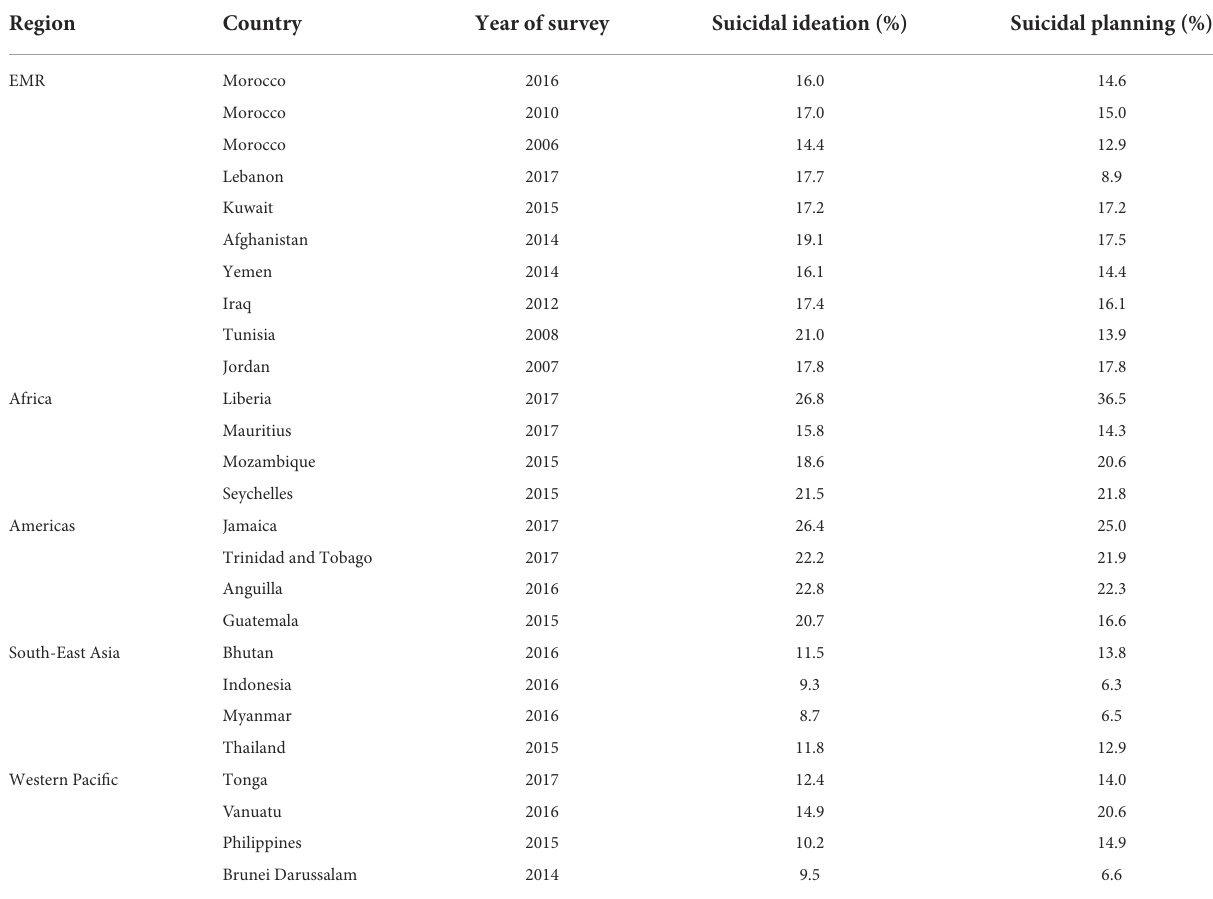
TABLE 1 Global trends of suicidal ideation and planning among school attending adolescents based on the GSHS across the 5 different regions. Region Country Year of survey Suicidal ideation (%)